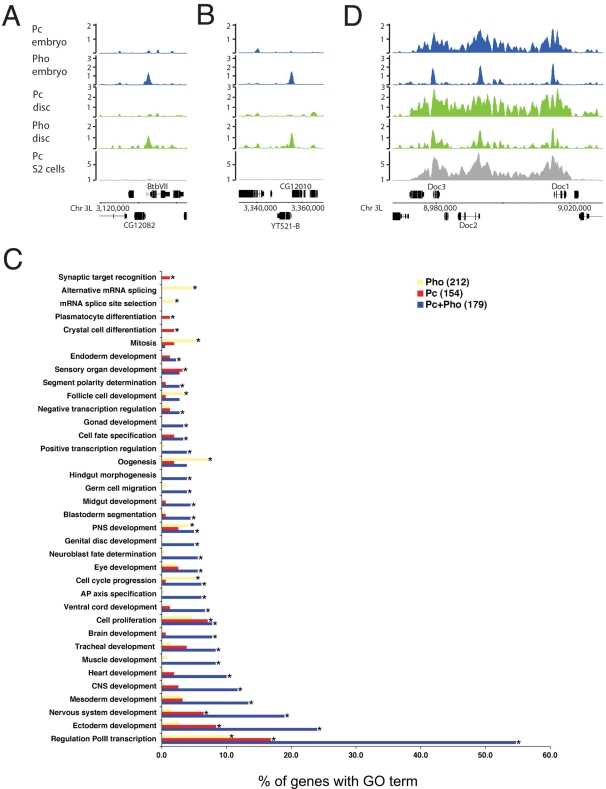
Pc and Pho targets.(A and B) show examples of targets that bind Pho in the absence of significant Pc binding. (C) shows the GO terms associated with specific gene sets derived from the embryo binding data. The “Pho” genes are positive for Pho binding but negative for Pc. The “Pc” genes are positive for Pc binding but negative for Pho. The “Pc+Pho” genes are positive for both. Significantly enriched (corrected p value <0.05) GO terms are indicated with an asterisk. The “Pho” gene set stands out as enriched for certain GO terms including oogenesis, mitosis and alternative mRNA splicing. (D) Enrichment profiles for a selected region comparing the “domain” binding of Pc with the sharper Pho profile.